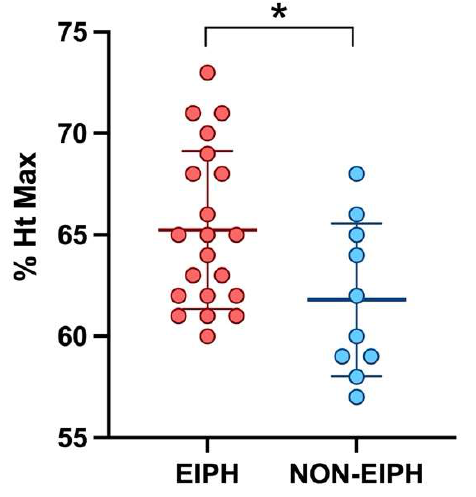
Figure 1. Scatter plot showing the mean and standard deviation of the maximum hematocrit reached during exercise in EIPH and non-EIPH horses. The statistical significance is shown as * ( p < 0.05).